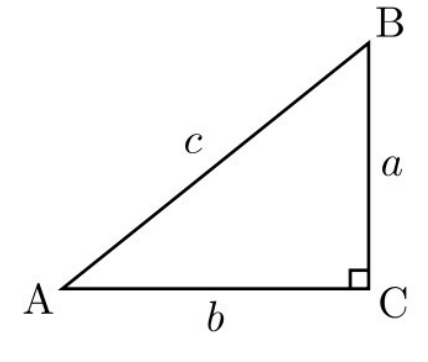
Figure 1. Pythagoras theorem: c 2 = a 2 + b 2